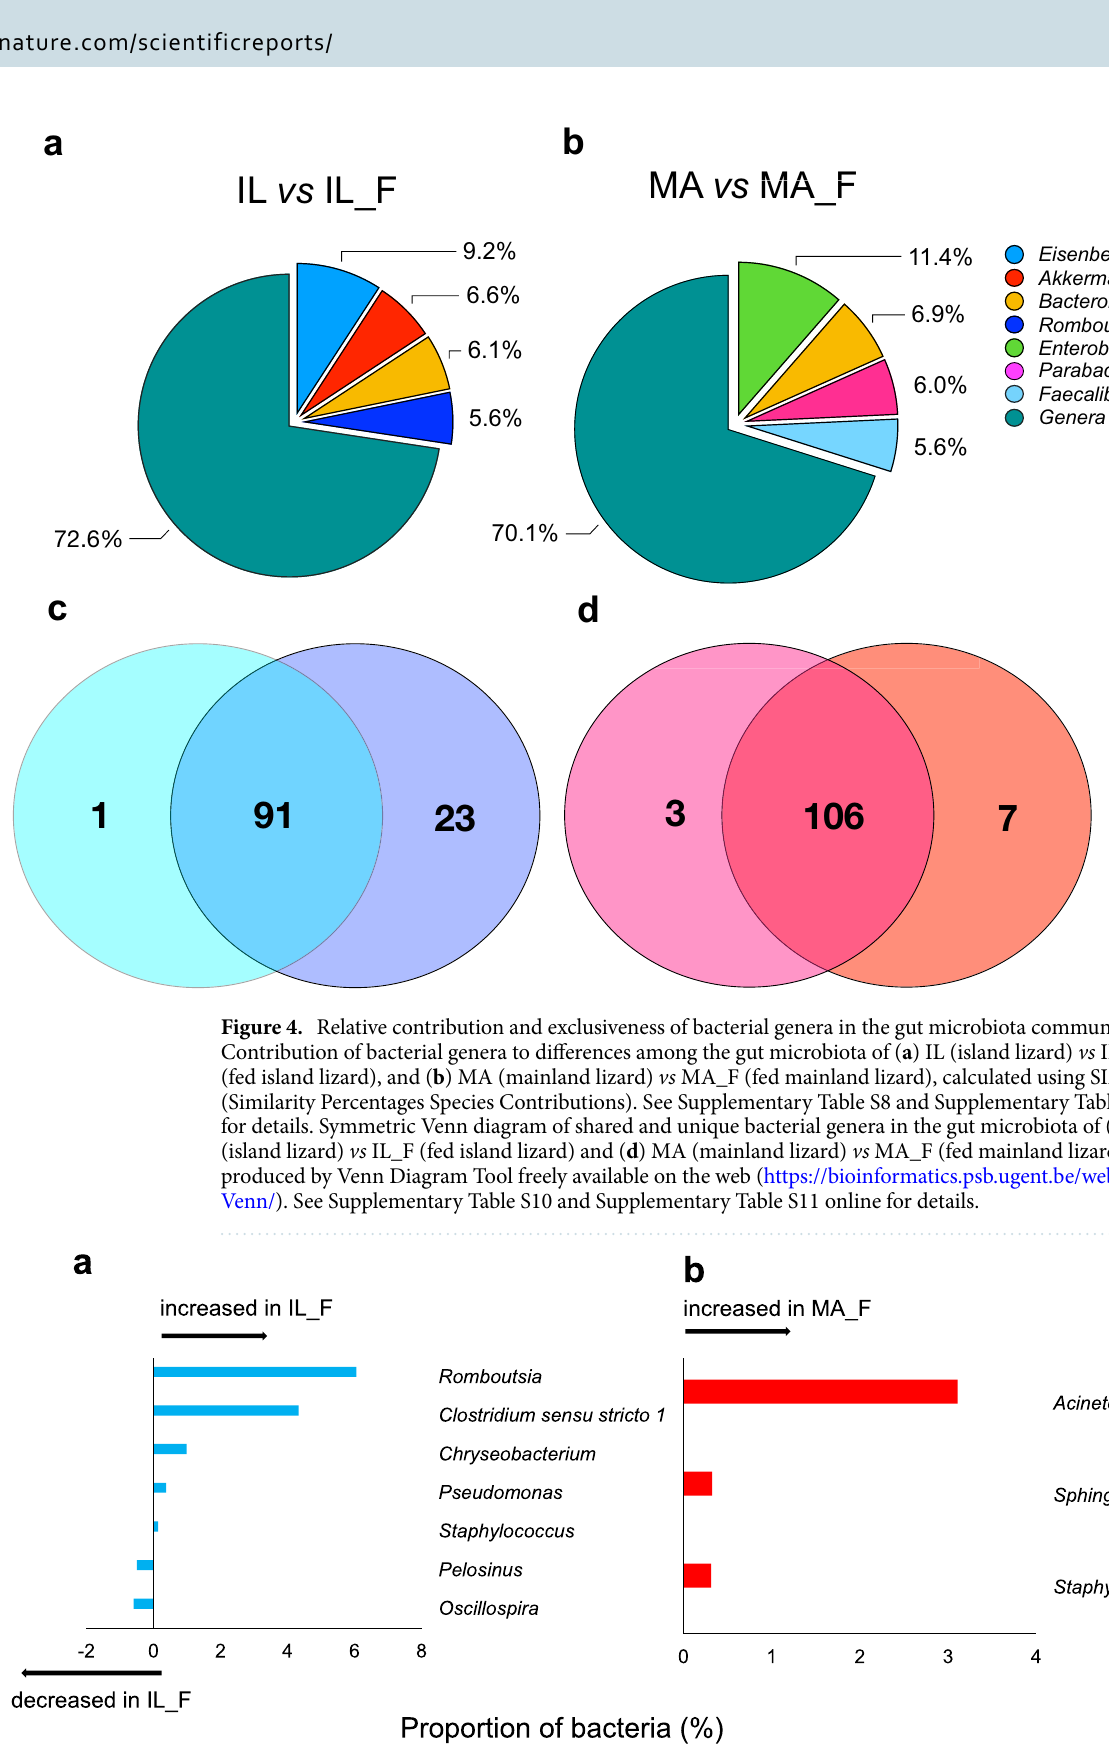
Figure 5. Differentially represented genera among the gut microbiota. Differentially represented genera (amount of bacteria %) among the gut microbiota of ( a ) IL (island lizard) vs IL_F (fed island lizard) and ( b ) MA (mainland lizard) vs MA_F (fed mainland